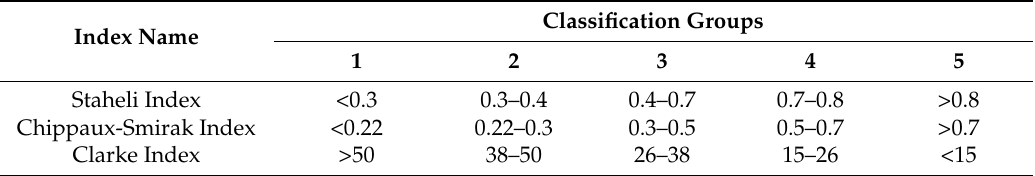
Table 3. The range for the classification into five groups of footprints whereas: 1—Cavus